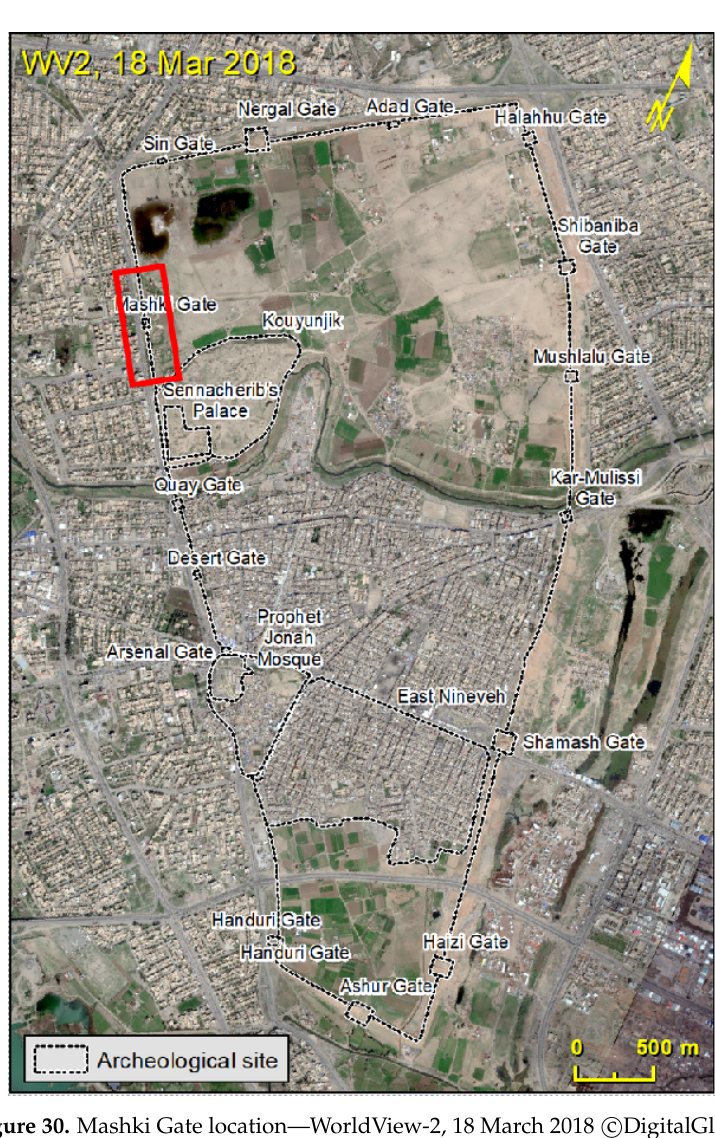
Figure 30. Mashki Gate location—WorldView-2, 18 March 2018 c (cid:13) DigitalGlobe.